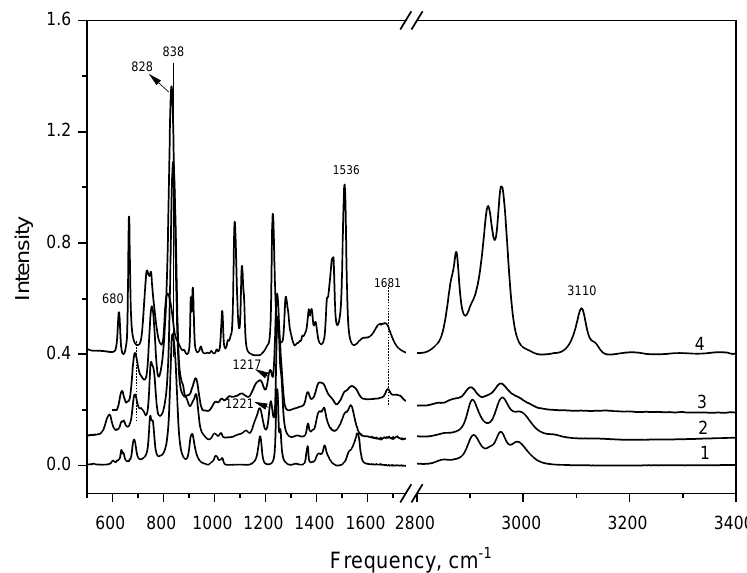
Figure 2. The IR spectra of PTMSP (1 PTMSP, containing 60 mol% Br (2), PTMSP, containing 5 mol% butylimidazole salt (3), N -butylimidazole (4).